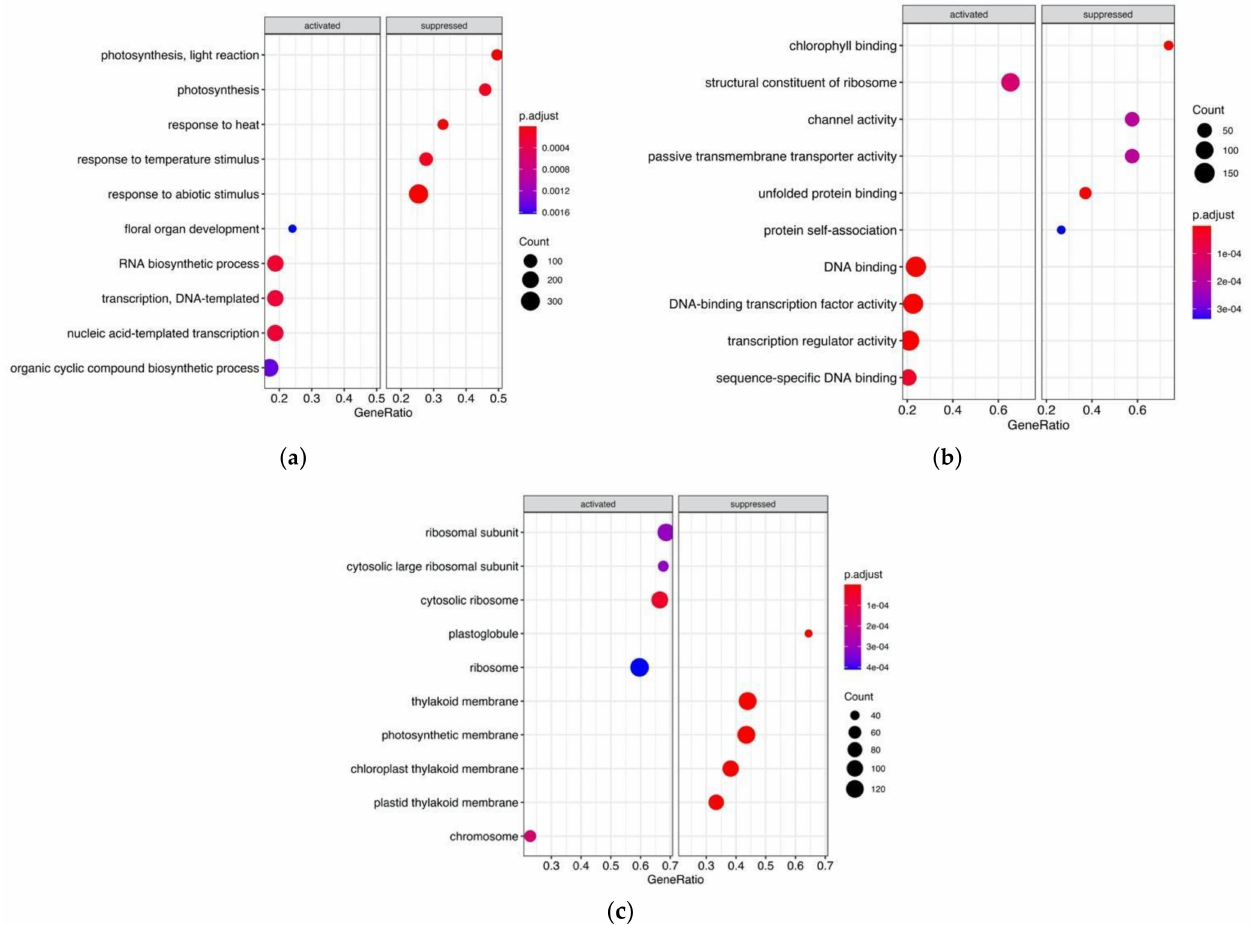
Figure 2. Clusterprofiler GO enrichment results showing activation or suppression of genes in Early flowering guar geno- types in comparison with Late flowering genotypes for the functional categories: ( a ) Biological Process (BP); ( b ) Molecular Function (MF); ( c ) Cellular Component